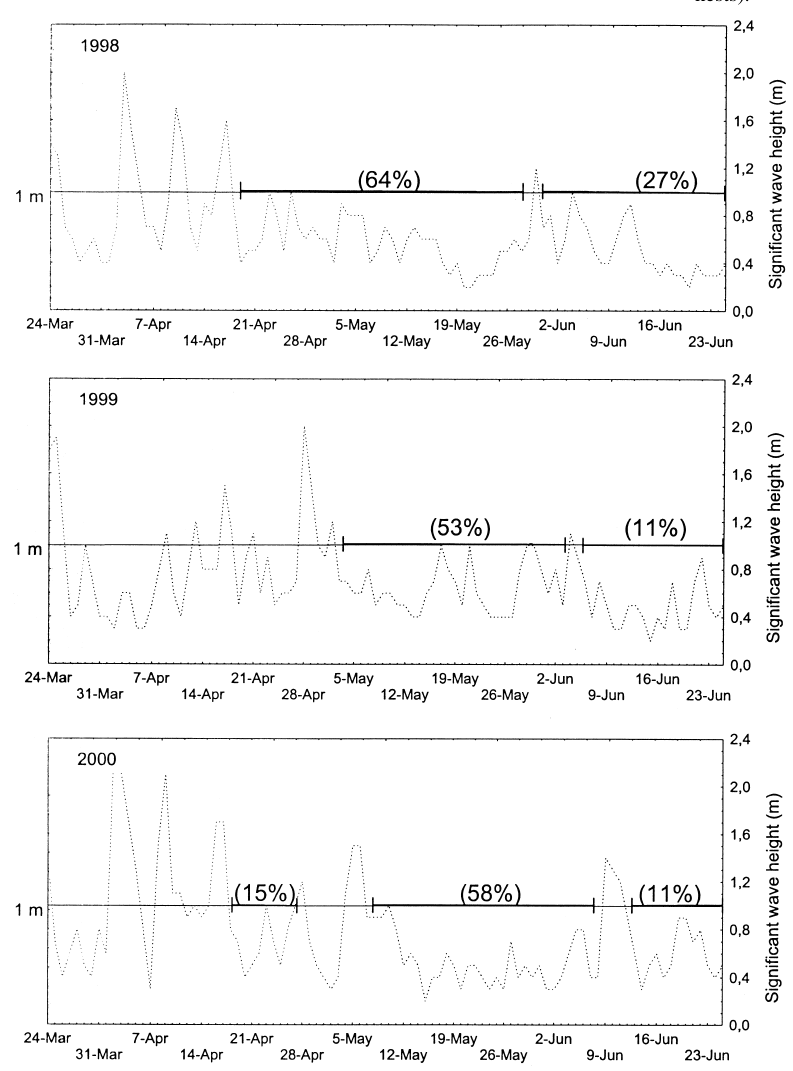
Fig. 5. – Dotted line = significant wave height (mean of the highest third of measured wave heights) during the entire spawning period over the 3 years of the study. Horizontal fine line marks the level of favourable sea conditions (< 1 m wave height). Bounded thick lines define sufficiently protracted periods (> 1 week) with favourable sea conditions allowing nest completion. In brackets are % of surviving nests during such